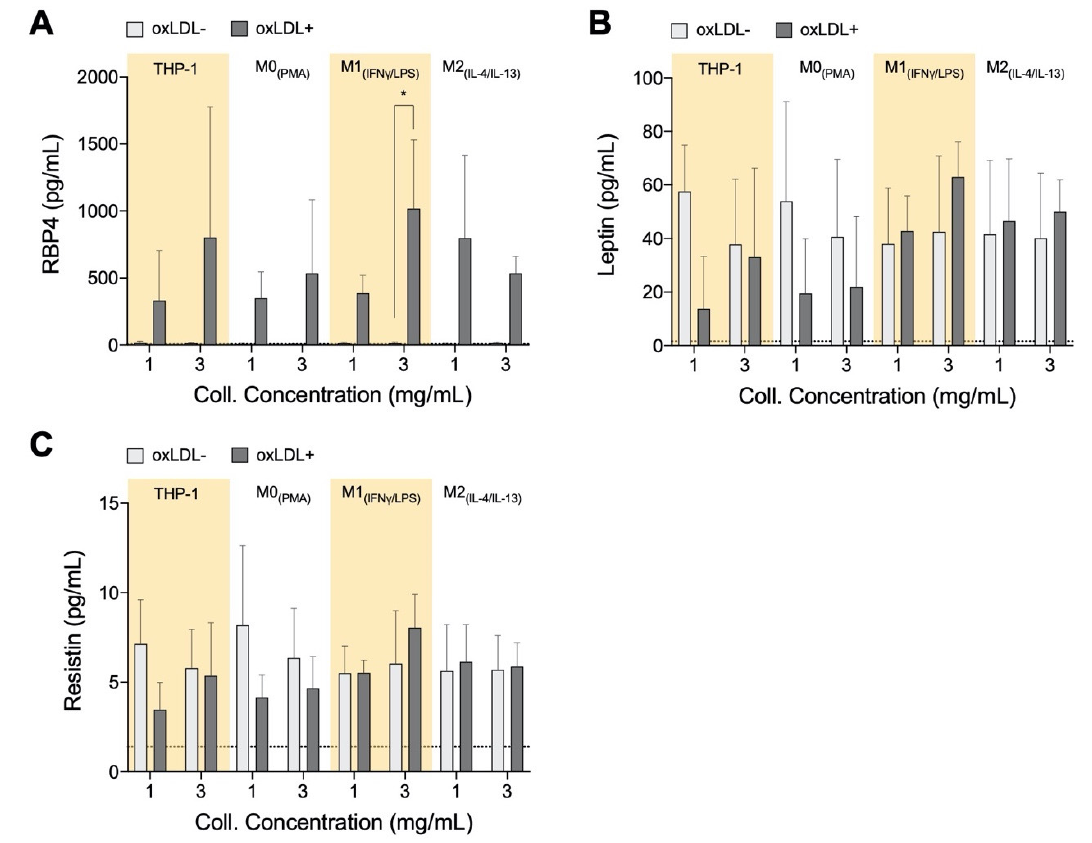
Figure 3. Adipokine secretome from monocytes and macrophages cultured in 3D collagen hydrogels. Box plots of absolute secretion levels of ( A ) RBP4, ( B ) leptin, and ( C ) resistin to observe trends and indicate comparisons that are statistically significant. The dotted line in the box plots marks the lowest detectable concentration of assay. Statistical significance has been determined by two-way ANOVA followed by Tukey’s test, and the level of significance is represented as * p < 0.05, significantly higher than the untreated sample at the same matrix density condition, no significance otherwise.